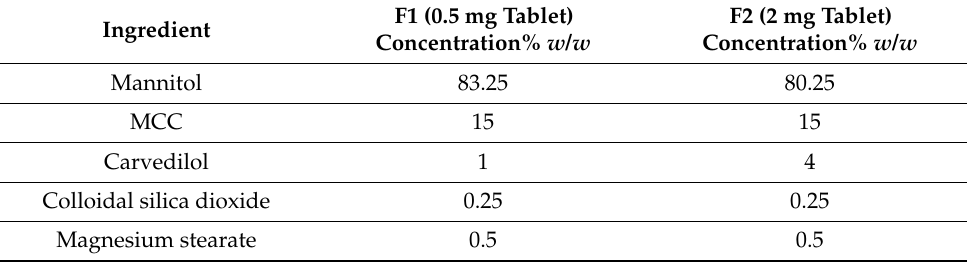
Table 1. Formulation composition for 500 and 2000 µ g carvedilol mini ODT